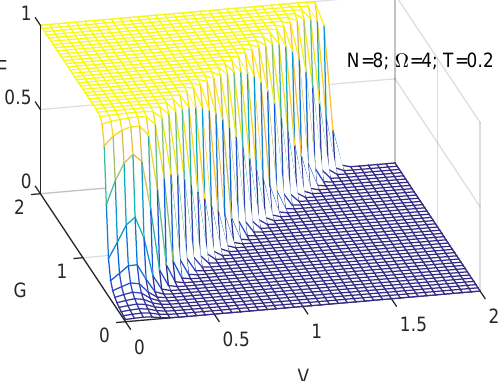
Figure 3. Superconductivity indicator H = X versus monopole coupling constant (cc) V and pairing force cc G . We have N = 8 and T = 0.2. Intense monopole forces destroy pairing. Weak ones, instead, favor it.